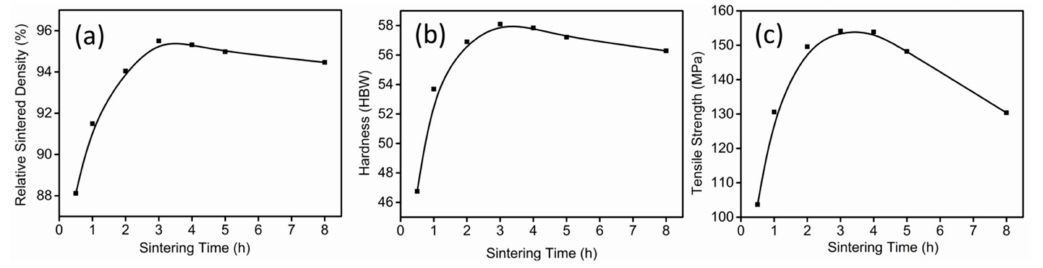
Figure 8. ( a ) Relative sintered density; ( b ) hardness; and ( c ) tensile strength of parts sintered at 550 ◦ C for different sintering times.